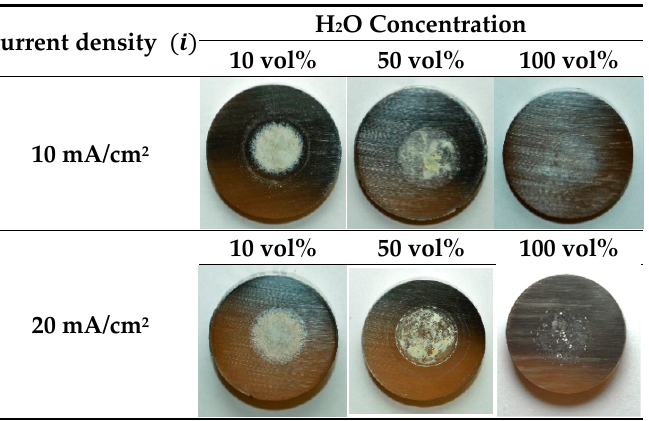
Figure 1. Photographs of 304L SS after anodizing in glycerol electrolyte containing 0.3 M NaAlO